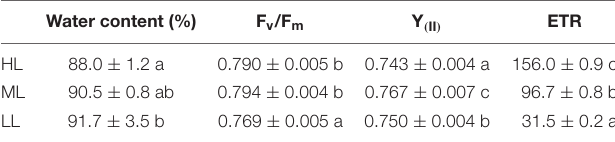
Chlorophyll a fluorescence parameters were determined on leaf 2. Values represent mean and SD. F v /Fm: maximum photochemical quantum yield of PS II; Y (II)